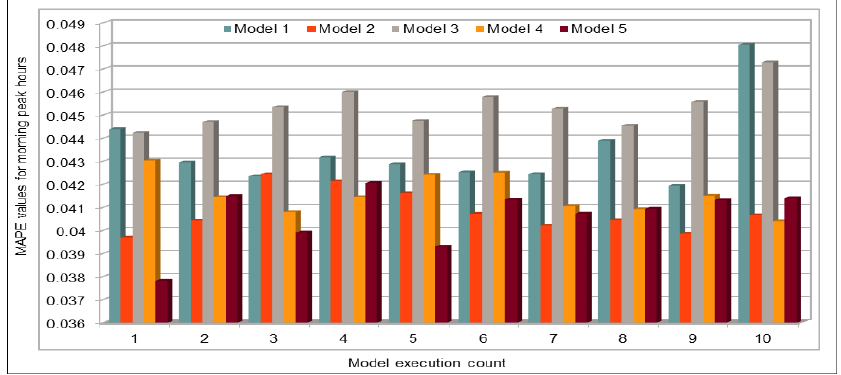
Figure 19. MAPE calculated by comparing actual and predicted vehicles flow on morning peak